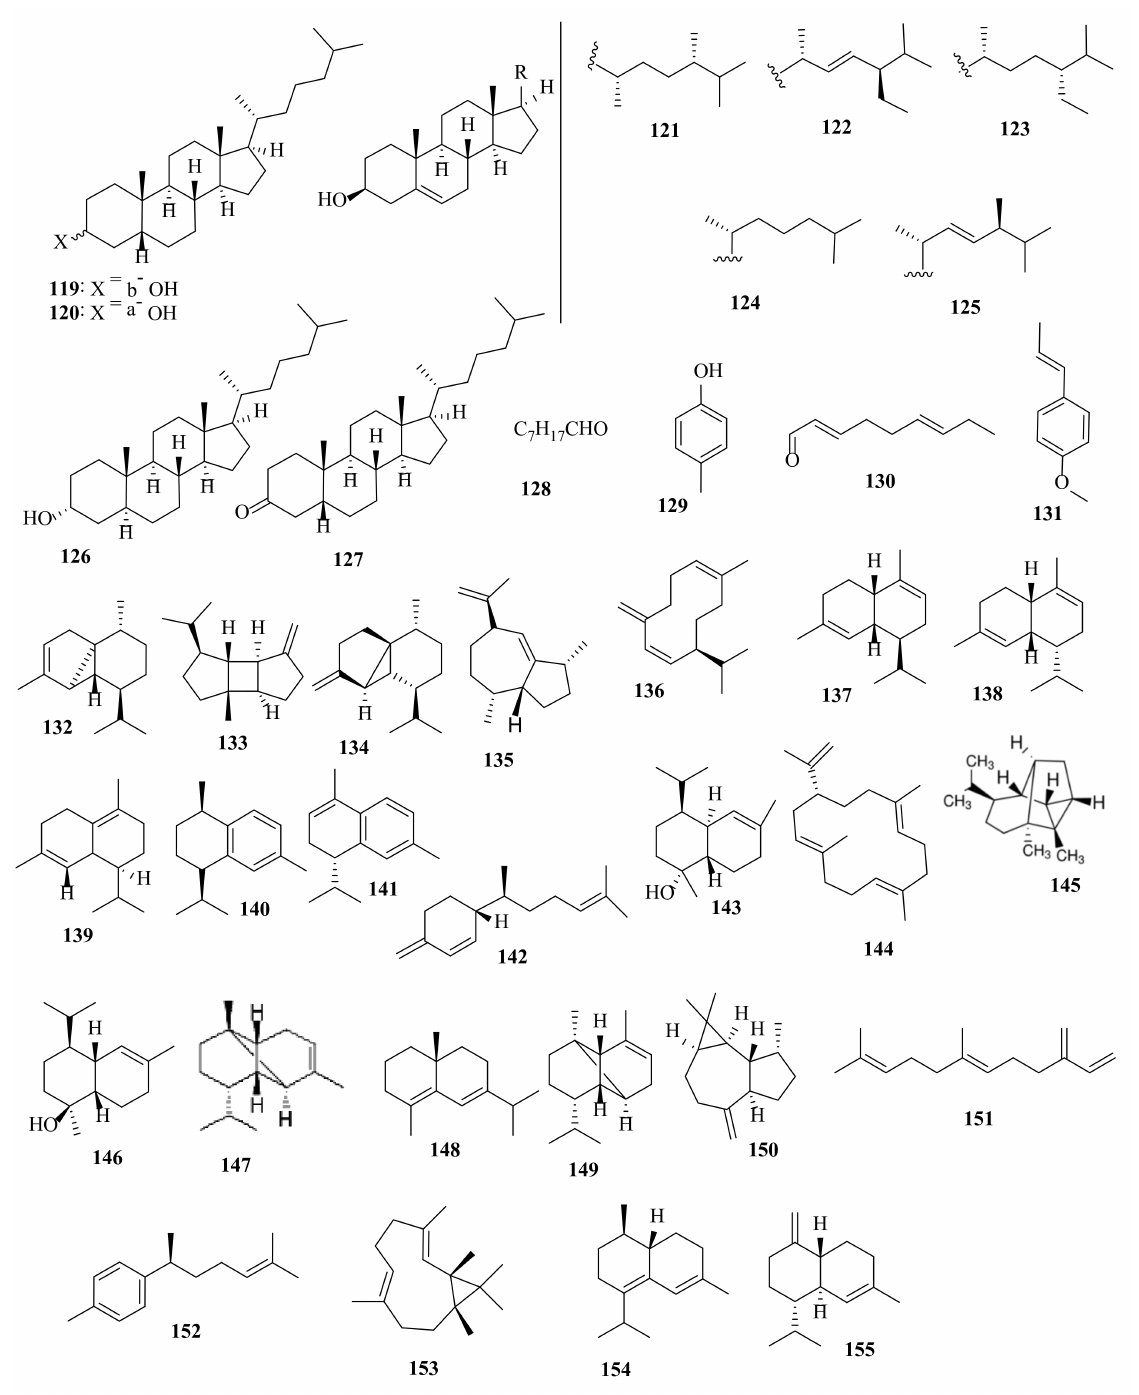
Figure 6. Chemical structures of compounds 119 – 155 . Sterols 119 – 127 , aldehydes 128 and 130 , aromatic derivatives 129 , 131, and 152 , diterpenes 132 – 133 , sesquiterpenes 134 – 150 and 153 – 154 , and hydrocarbon 151 were isolated from D. dichotoma . The configuration of all stereocenters in each compound is shown as given in the